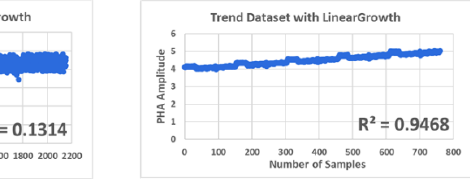
Table 2. Results of the confusion matrices generated for each case.